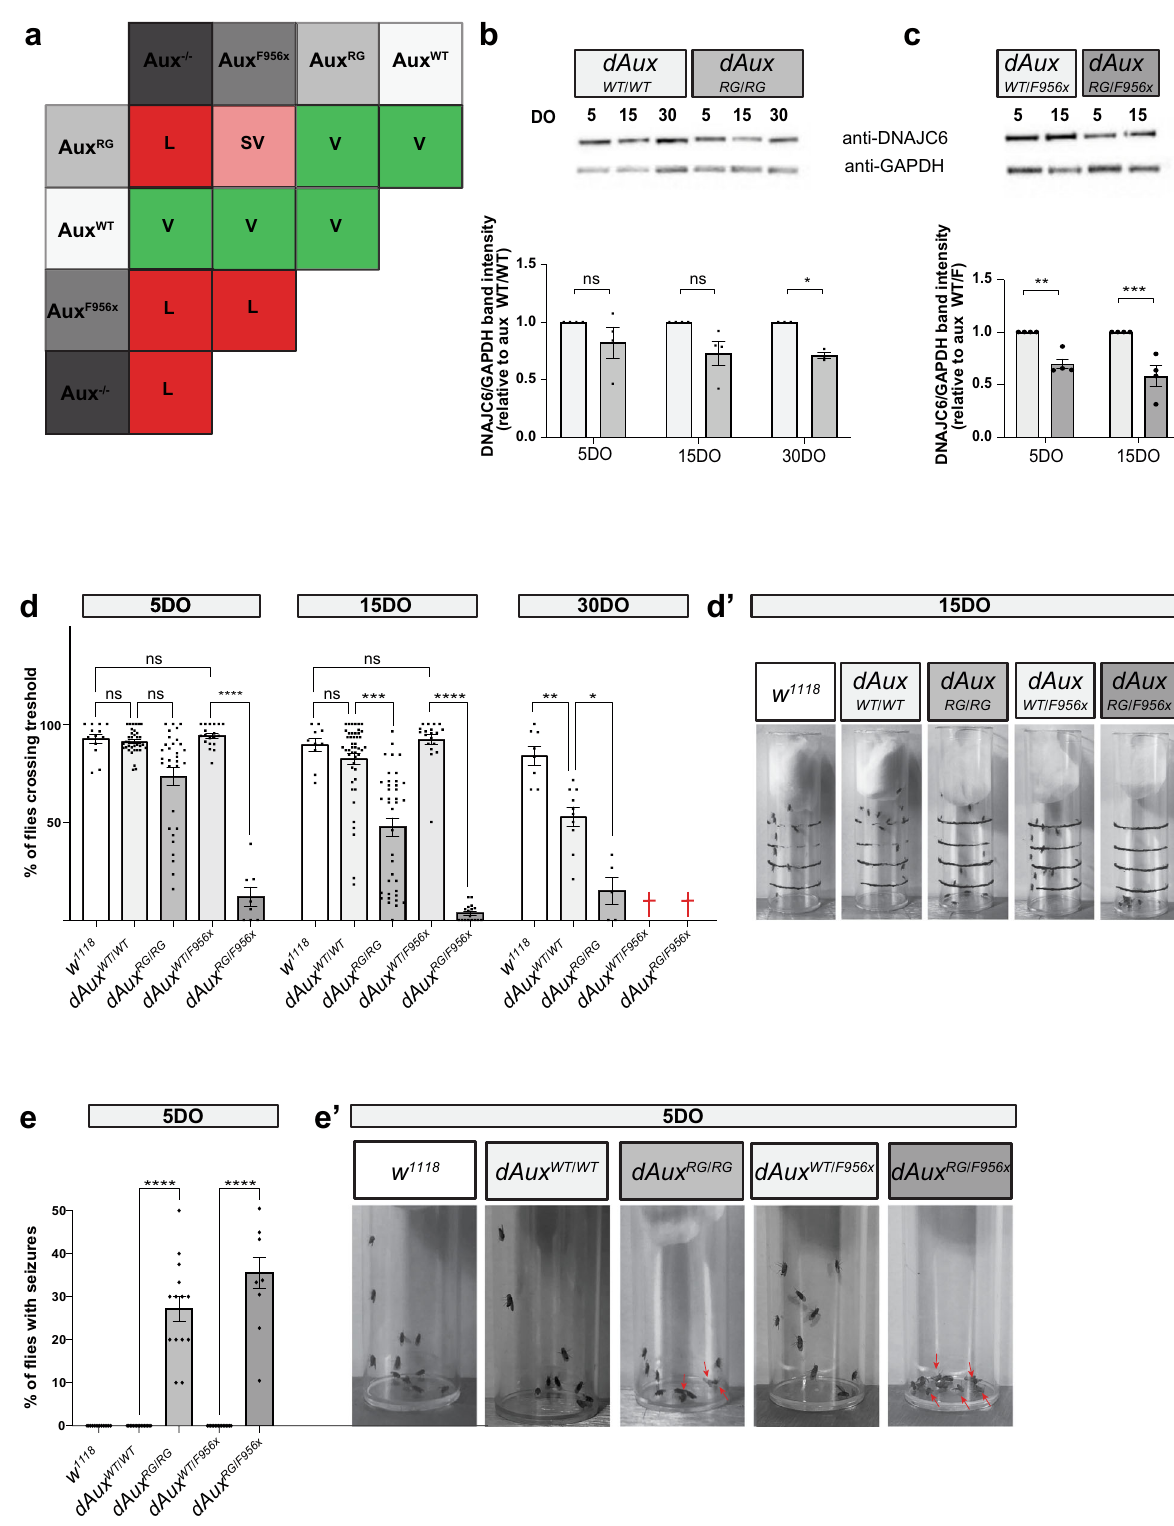
F956X and dAux RG/F956X (the latter two only at 5 and 15DO). Interestingly, a decrease of Auxilin protein levels is observed over time, when compared to controls (Fig. 2b, c). Furthermore, the drop in protein levels is more pronounced when the R1119G and F956X mutations are combined compared to homozygous